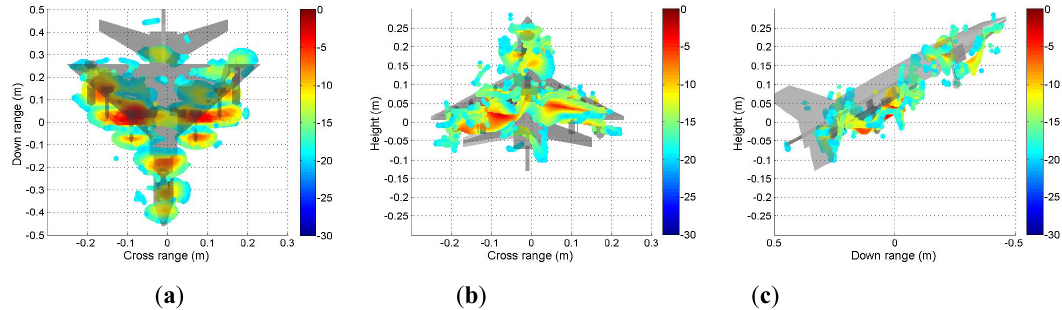
Figure 13. Tomography result in VV polarization. Three views of the airplane model are shown: ( a ) top view; ( b ) bottom view; ( c ) side view.